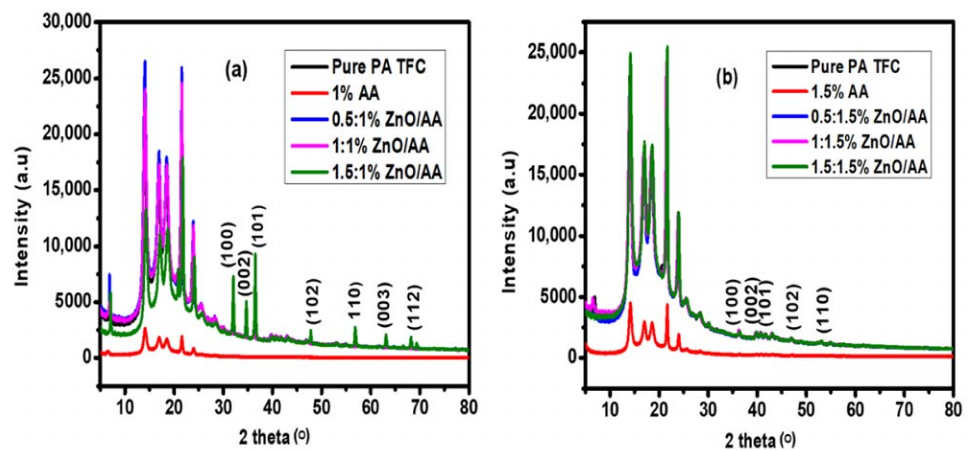
Figure 5. XRD spectra of: ( a ) unmodified membranes (0.00% ZnO/AA); and membranes modified by: 1.00% AA, 0.50:1.00% ZnO/AA, 1.00:100% ZnO/AA, and 1.50:1.00% ZnO/AA; and ( b ) membranes modified with 0.00% ZnO/AA, 1.50% AA, 0.50:1.50% ZnO/AA, 1.00:1.50% ZnO/AA, and 1.50:1.50%